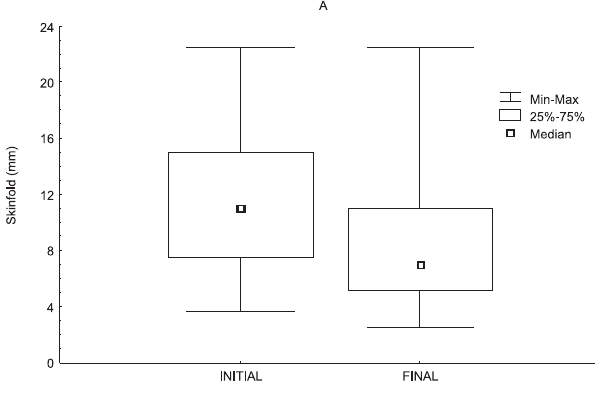
Figure 3 - Triceps ( A ) and thigh ( B ) skinfolds before and after one year of resistance